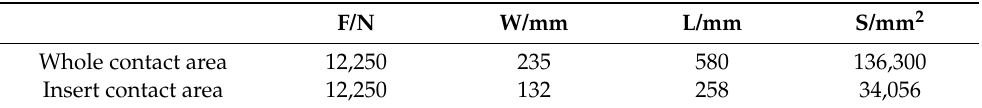
Table 1. Tire contact area parameters.